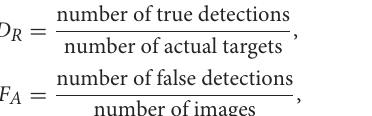
TABLE 1 Parameters of the feedback small target motion detectors (FSTMDs).